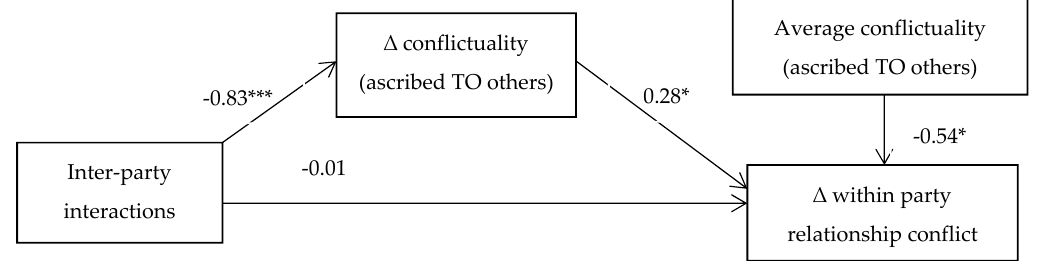
Figure 4. The overall mediation model for change in conflictuality and relationship conflict (top-down influence). Notes: * p < 0.05; *** p < 0.001, Δ relationship conflict = relationship conflict at time 2 minus relationship conflict at time 1, Δ conflictuality = the conflictuality as perceived by each party for the system as a whole at time 2 minus conflictuality at the system level at time 1.